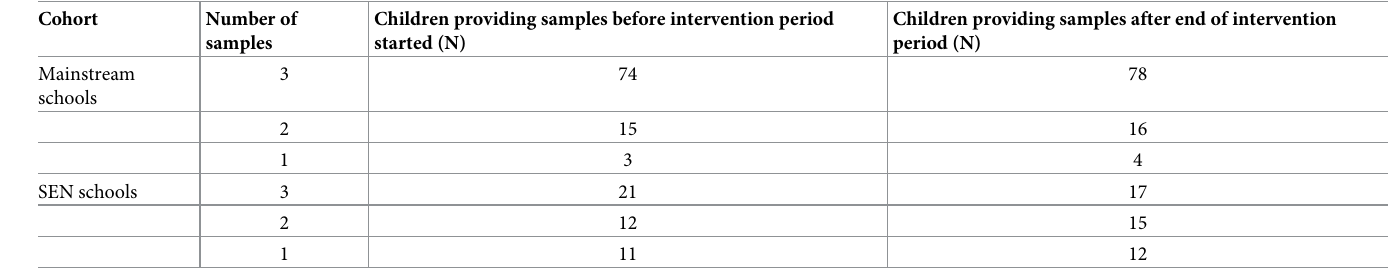
Table 1. Overview of samples